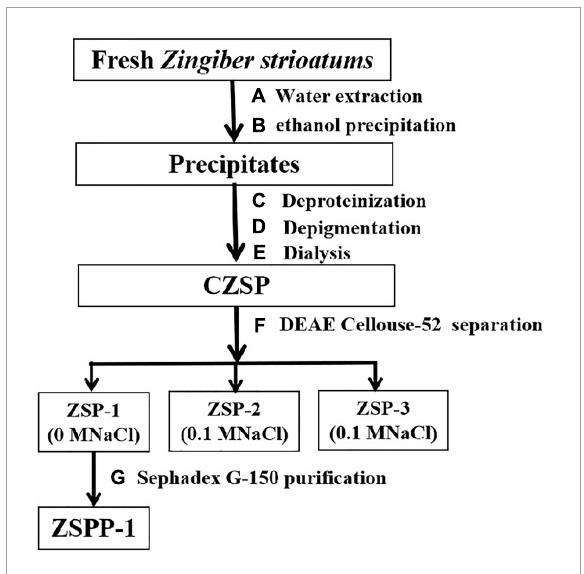
FIGURE1 The procedure of ZSPP-1 extraction and